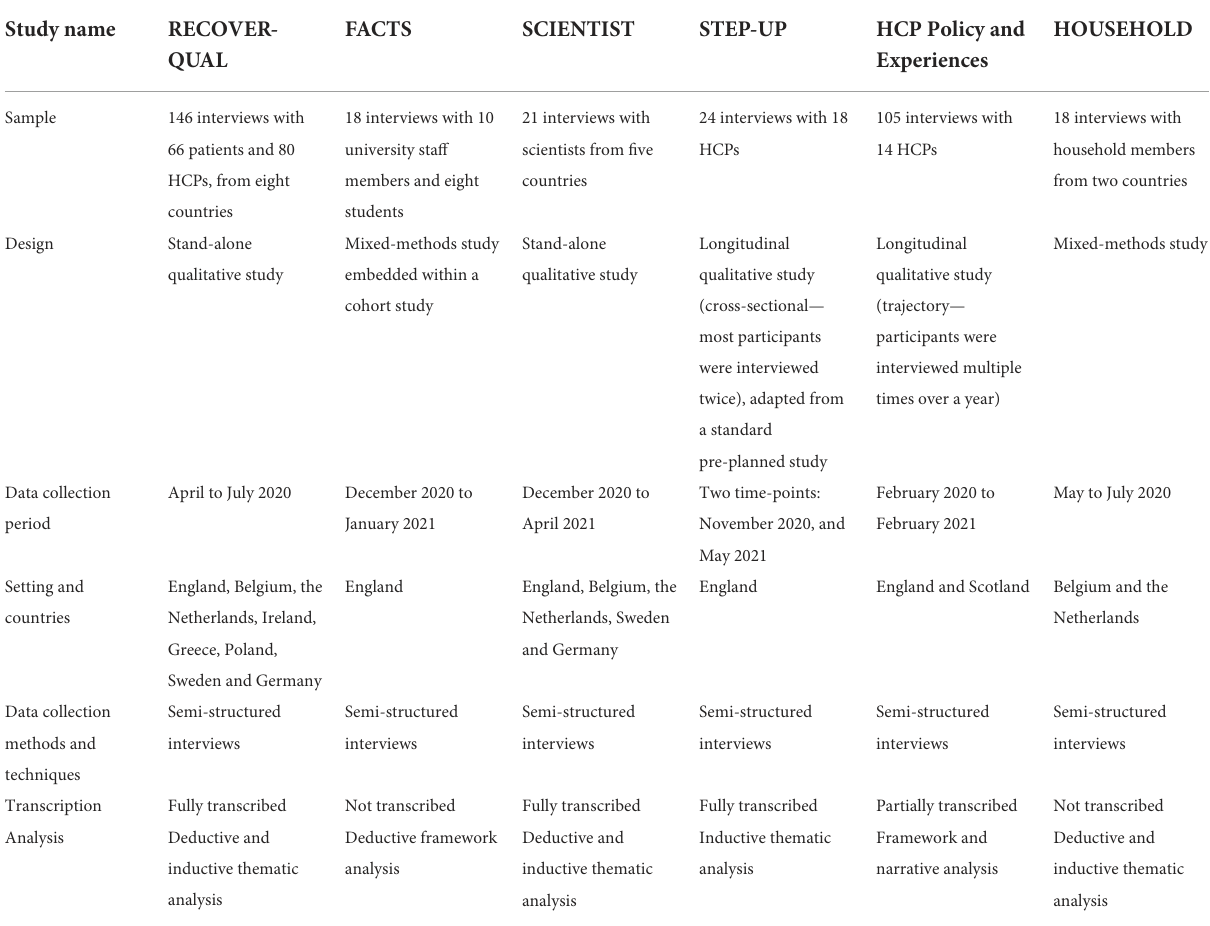
TABLE 1 Overview of conducted rapid